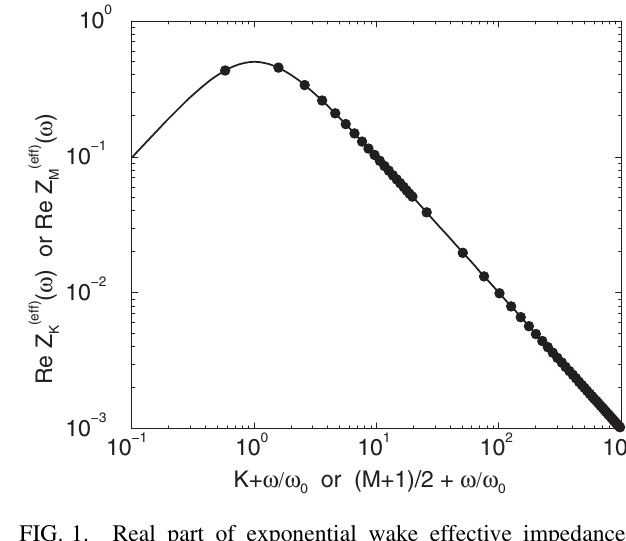
(cid:6) (cid:1) 0 : 425 , and any B ; 0